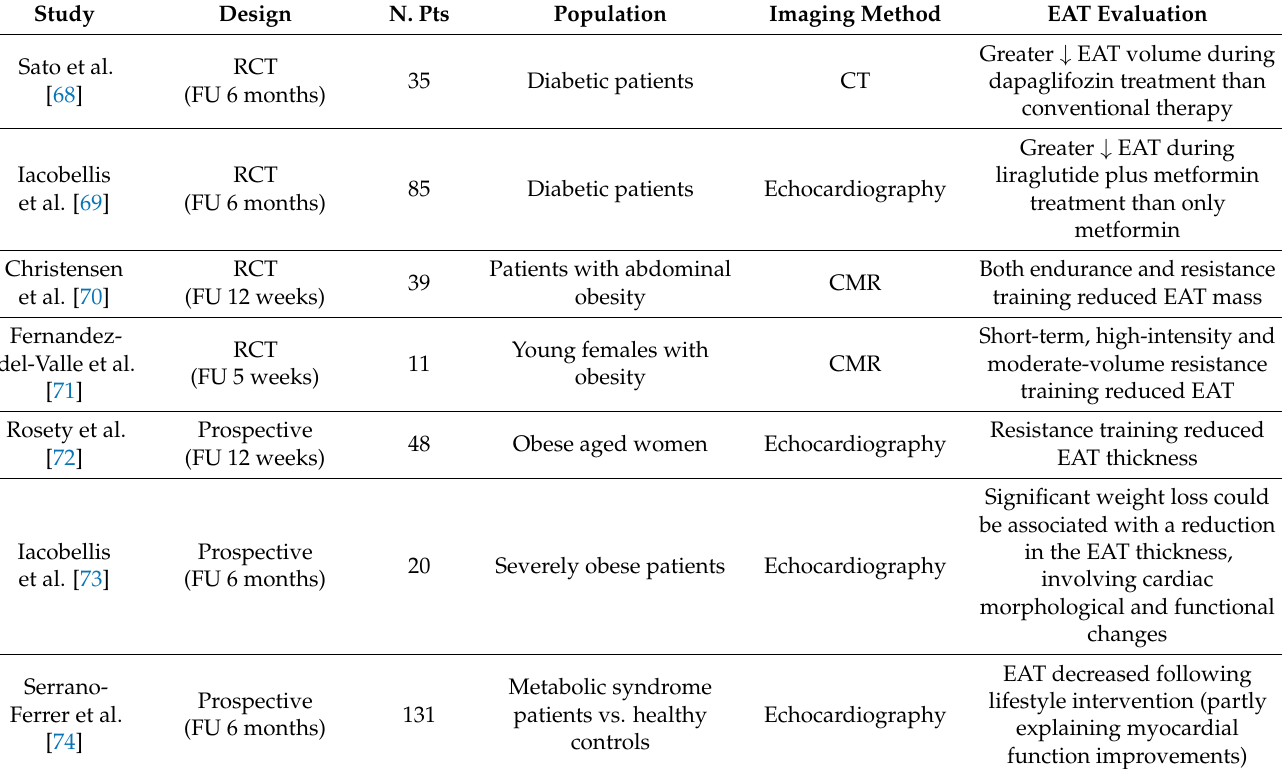
Table 2. Epicardial adipose tissue evaluation in metabolic